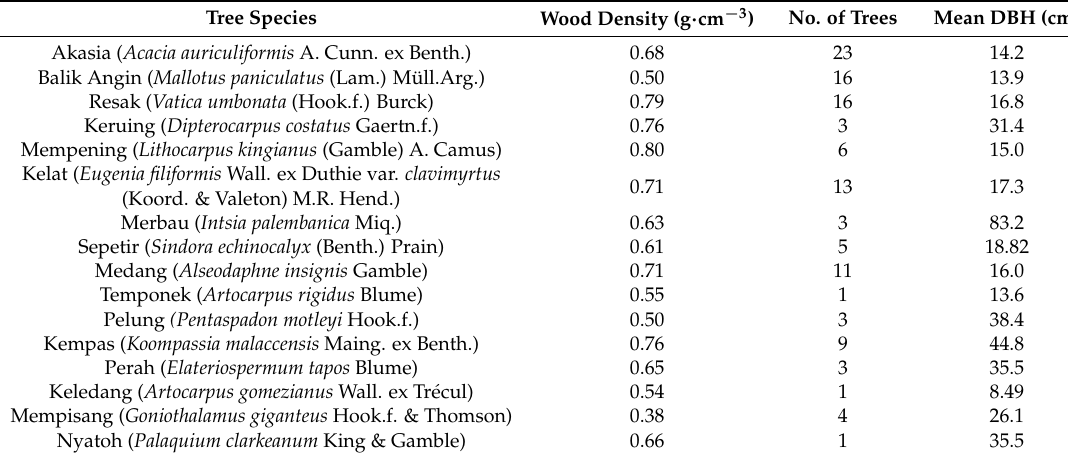
Table 1. List of tree species and wood density [28]. Tree